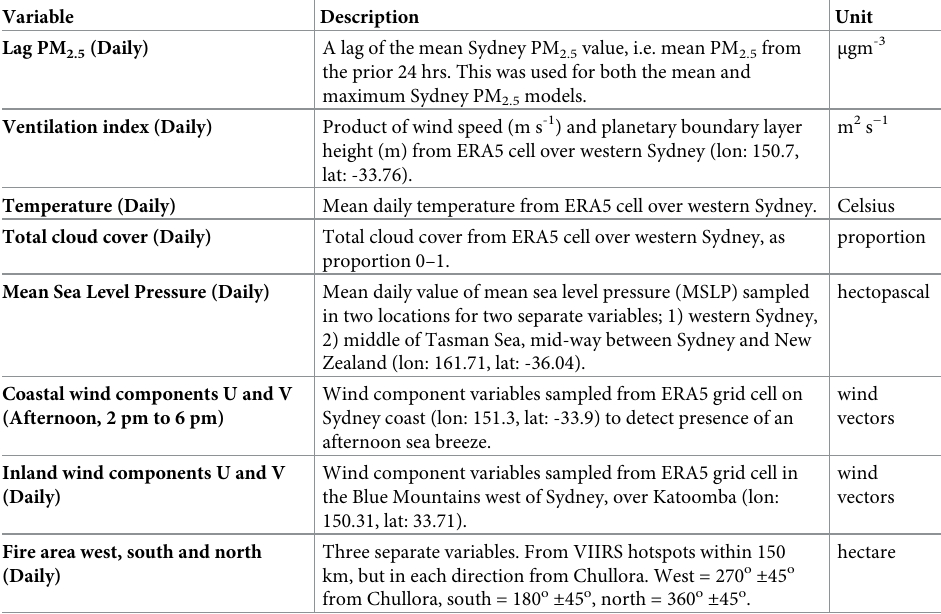
Table 1. Predictor variables used in